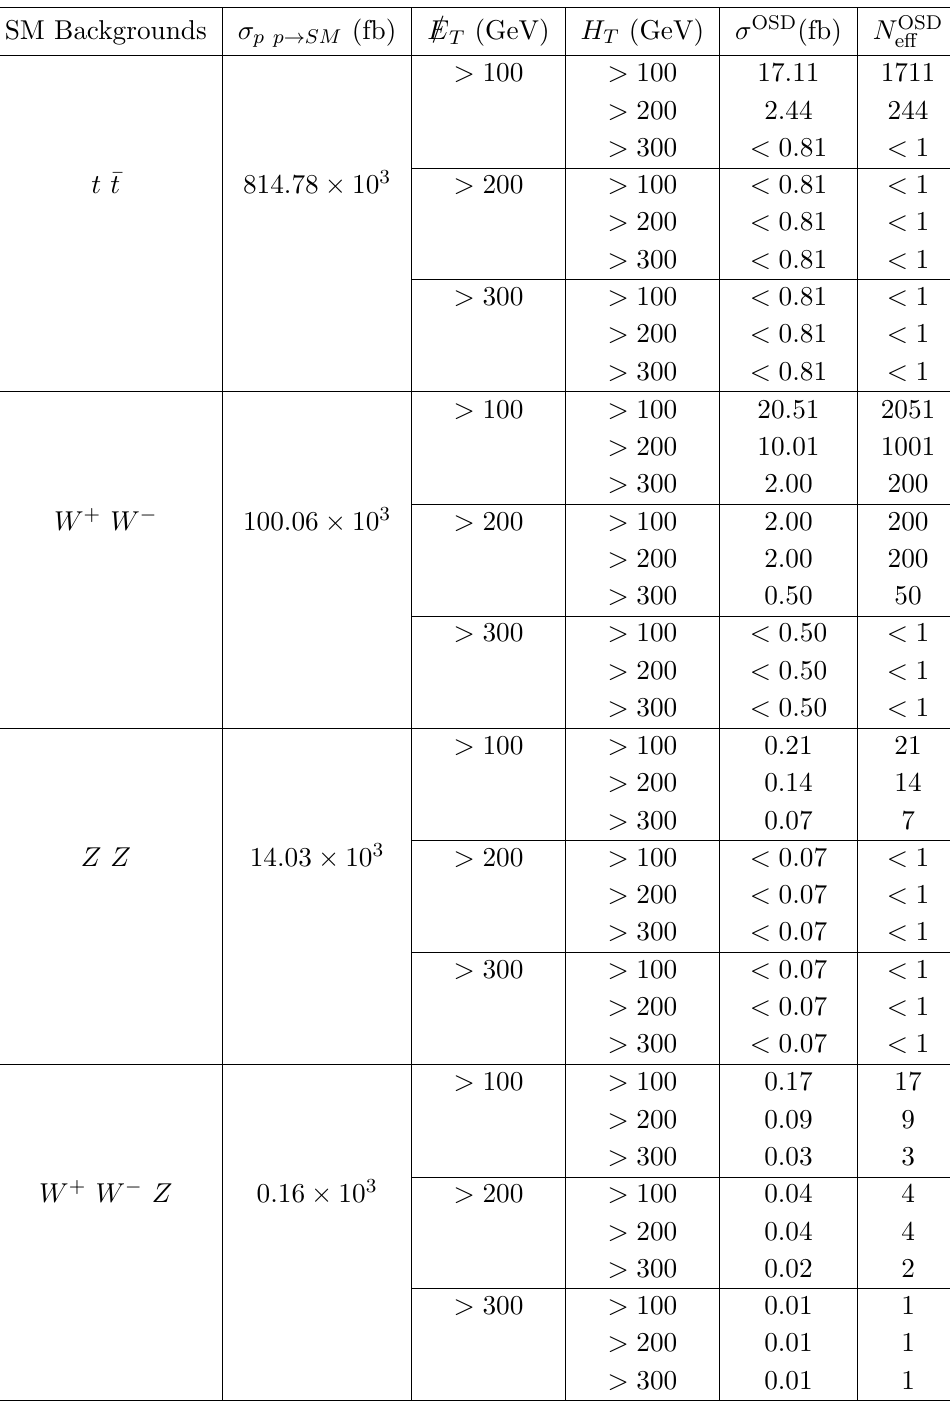
Table 5 . Dominant SM background contribution to ‘ + ‘ (cid:0) + ( =E